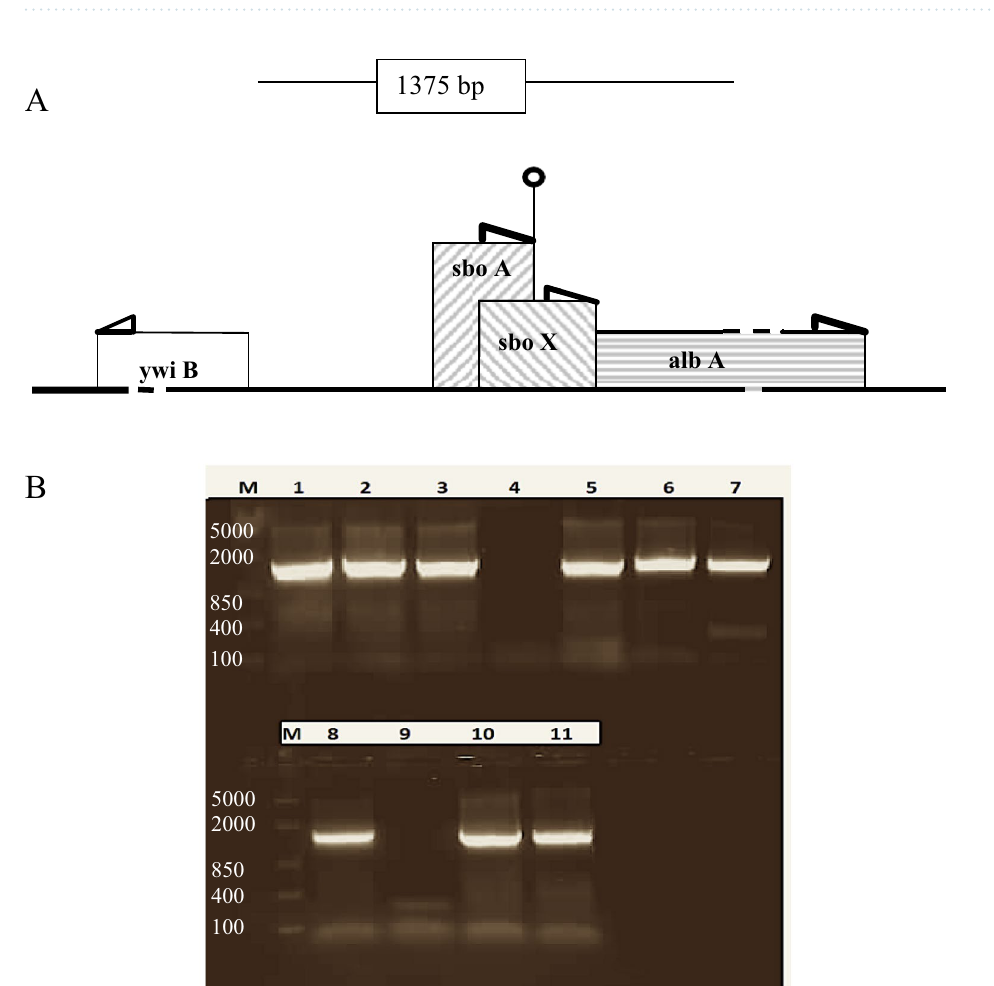
Figure 3. ( A ) Organization of the sboAX locus. the sboA , sboX , and albA region of the sbo-alb gene cluster and flanking region. Arrowheads indicate direction of transcription; (o) is a terminator. ( B ) PCR amplified fragment of 1375 bp related to sbo gene where M indicates marker (5000, 2000, 850, 400, 100 bp). Positive amplification for lanes 1–3, 5–7 corresponding to different B. subtilis isolates while lane 10 and 11 coorsponds to B. amyloliquefaciens and B. subtilis ATCC6633 respectively. Lane 8 is a positive control ( B. subtilis 168) and Lane 9 is a negative control ( B. licheniformis